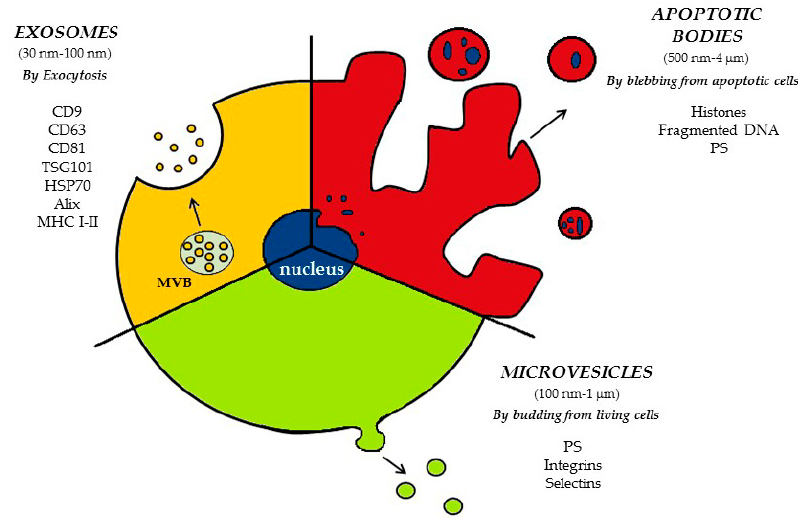
Figure 1. Mechanisms of extracellular vesicle (EV) release and their specific markers. Apoptotic bodies (ApoBDs) are released by membrane blebbing of apoptotic cells; microvesicles (MVs) bud directly from the plasma membrane of living cells, while exosomes are formed as the intraluminal vesicles (ILVs) by budding into early endosomes and multivesicular bodies (MVBs) and are released by exocytosis. PS: phosphatidylserine; MHC: major histocompatibility complex; TSG101: tumor susceptibility gene 101 protein; HSP70: heat shock 70 kDa protein.